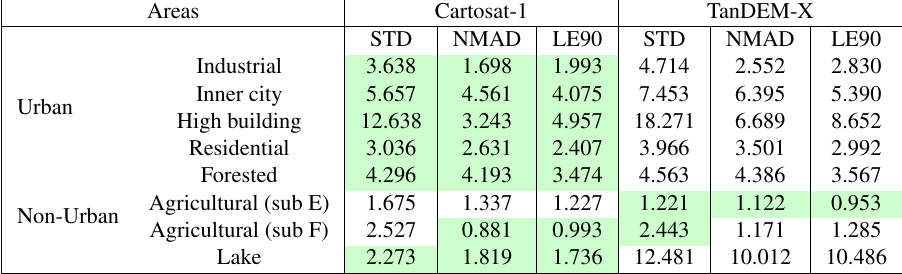
RMSE of the high building subset deviates from the trend line because strong height changes appear in this subset.